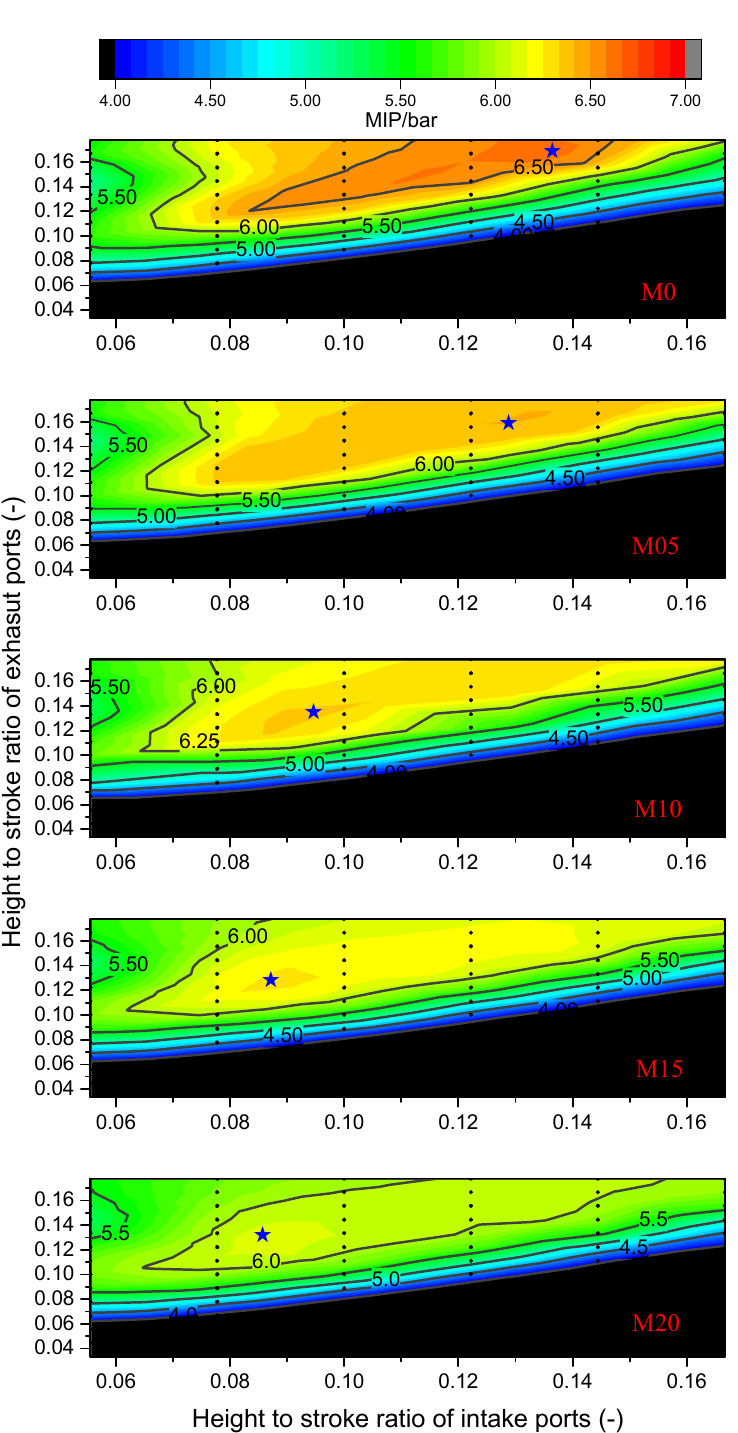
Figure 8. MIP for the interaction of the intake and exhaust ports.